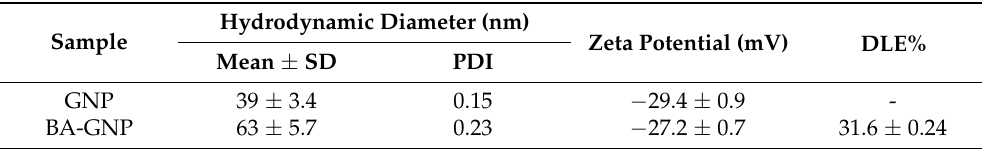
Table 2. Metallic content of GNP samples determined by X-ray fluorescence (XRF) analysis; only metals above 1000 ppm are shown.